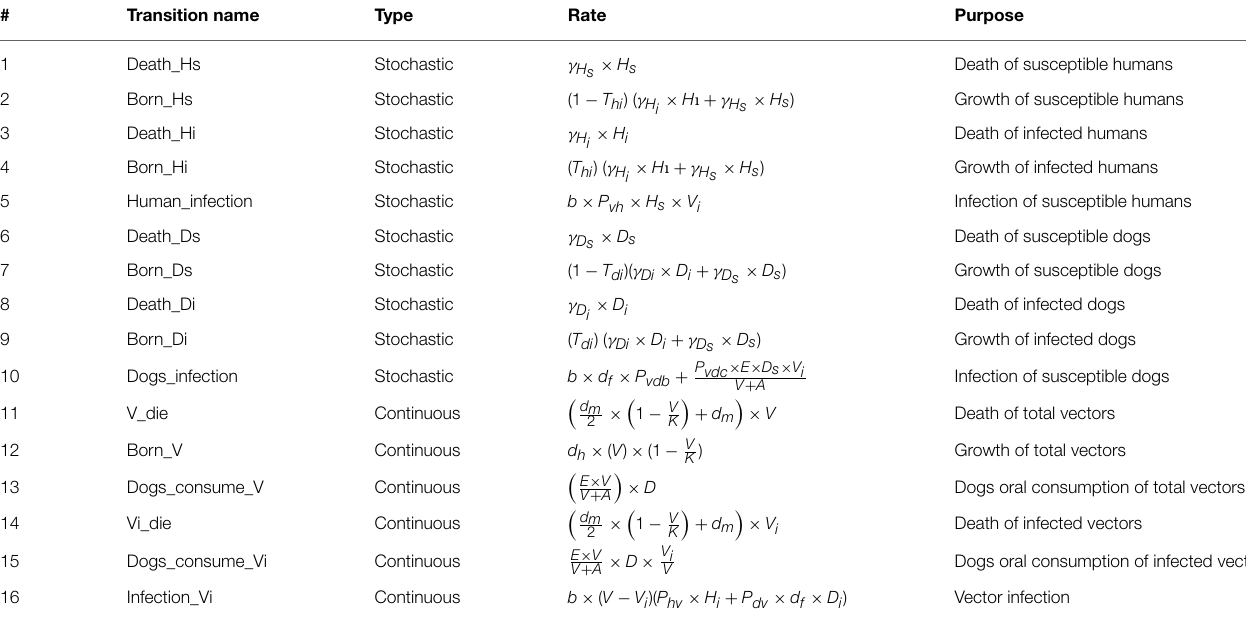
TABLE 1 | Detailed specification of the main transitions of the model in Figure